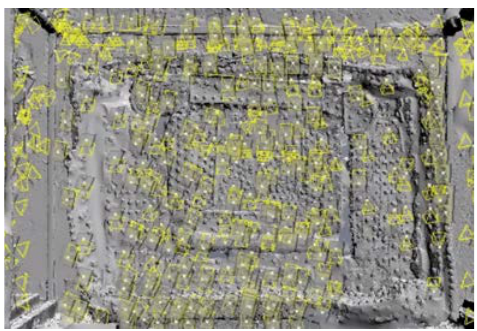
Figure 7. The photo positions from the top.